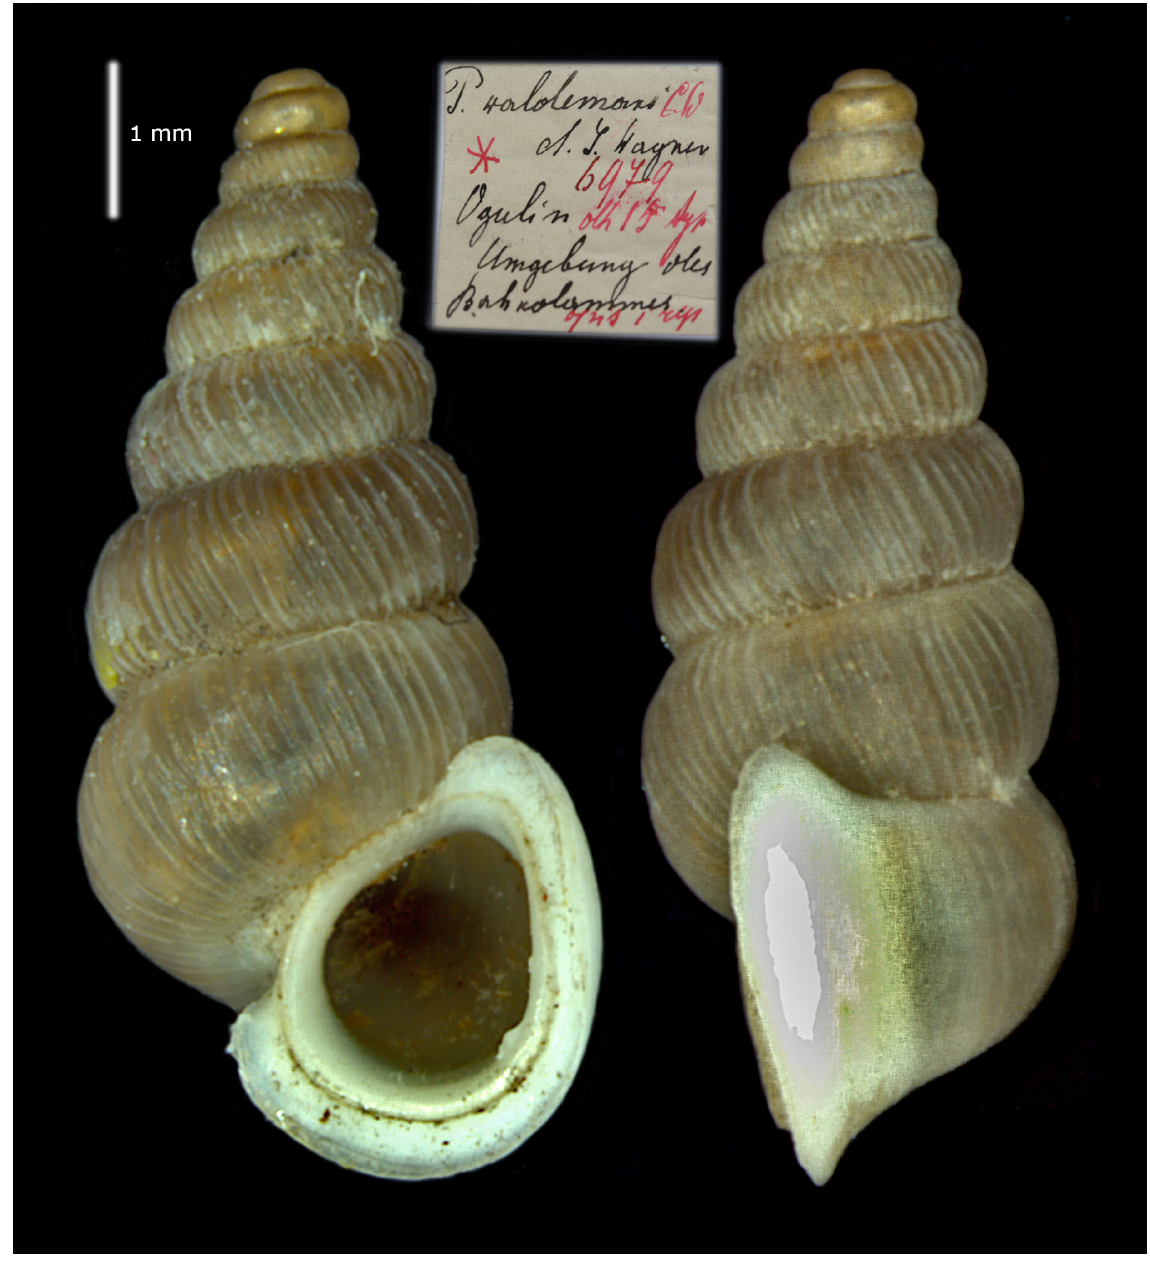
Fig. 33. Cochlostoma ( Clessiniella ) waldemari (A.J. Wagner, 1897), syntype, ♀, at the Muzeum i Instytut Zoologii PAN, Warsaw, Poland